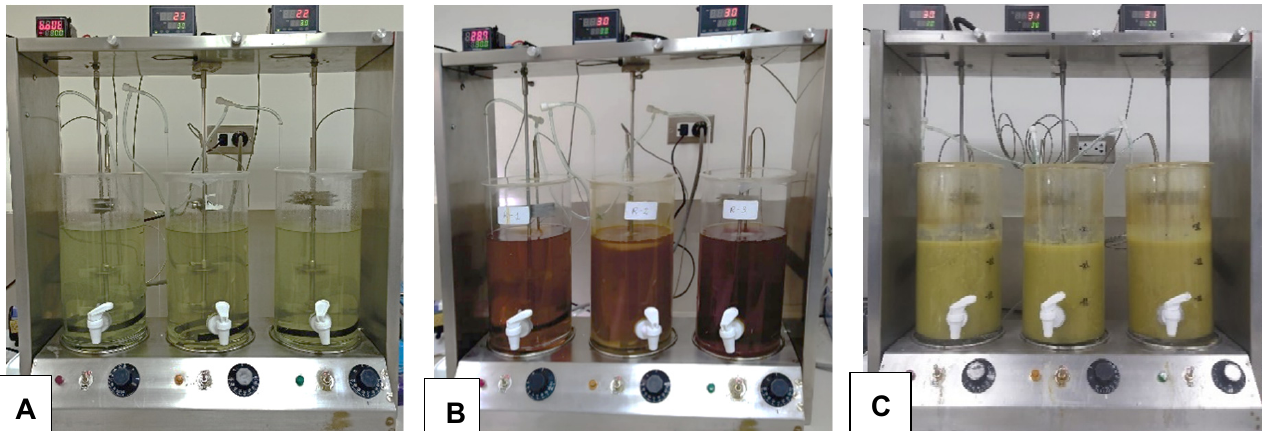
Figure 6. Bioleaching in stirred tank bioreactors coupled to an aeration system and operated at 30 ± 1 °C: ( A ) reactors with 4.5K culture medium and inoculated with 10% ( v / v ) of the enriched acidophilic iron-oxidizing bacterial consortium; ( B ) bio-oxidation of the 4.5K culture medium; ( C ) Bio-leaching solution.